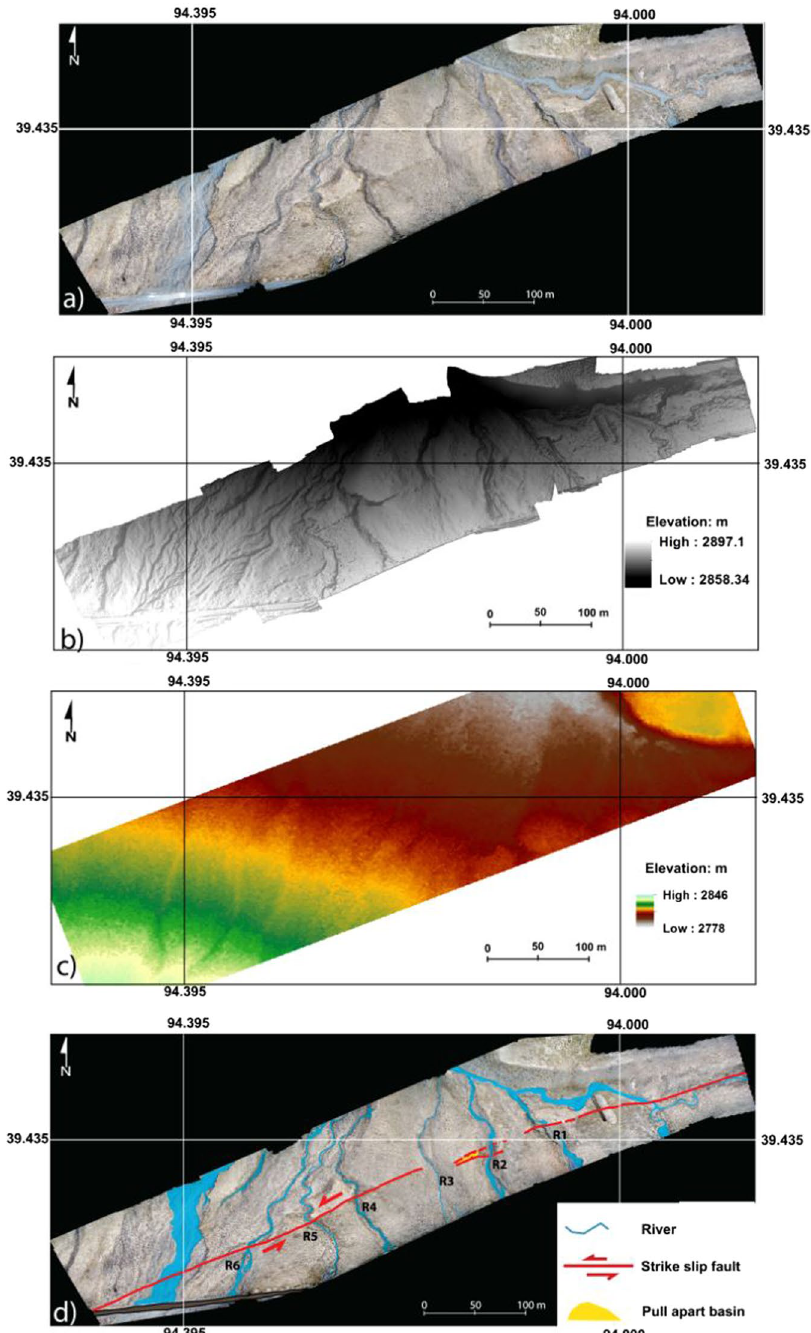
Figure 6. (a) Orthoimage (0.016 m resolution) of the study area. ( b ) High resolution bare earth digital elevation model (0.065 m resolution) from the UAV mapping. ( c ) Digital elevation model (0.5 m resolution) calculated from a stero pair of Pleiades satellite images. ( d ) The fault and the six streams (R1–R6) used in the reconstruction of the seismic